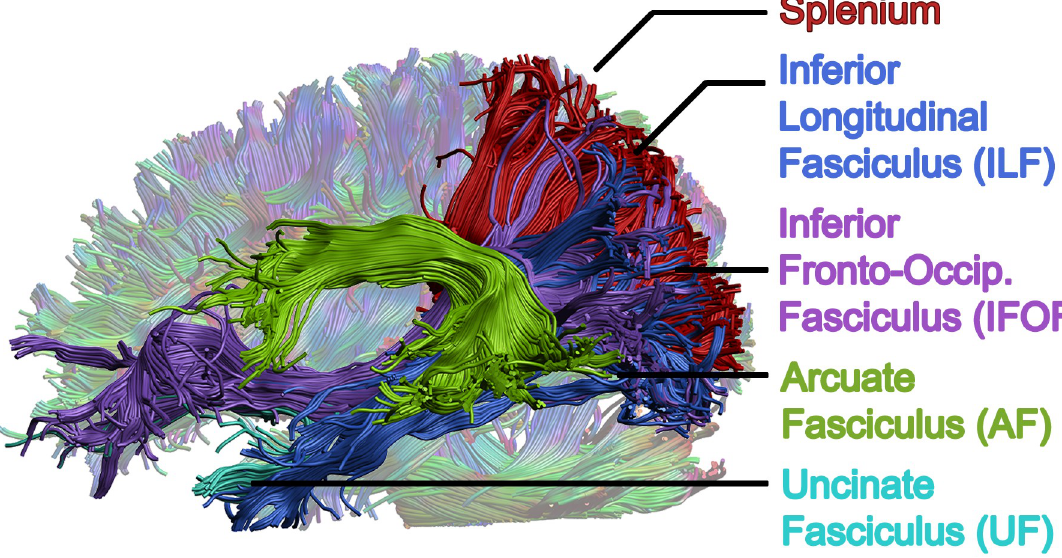
Fig 1. Major, reading-related white matter tracts chosen as regions of interest. Whole brain tractography was performed via constrained spherical deconvolution, then tracts were segmented using deterministic semi-automated methods in ExploreDTI. Regions of interest were investigated bilaterally, but only the left hemisphere is shown